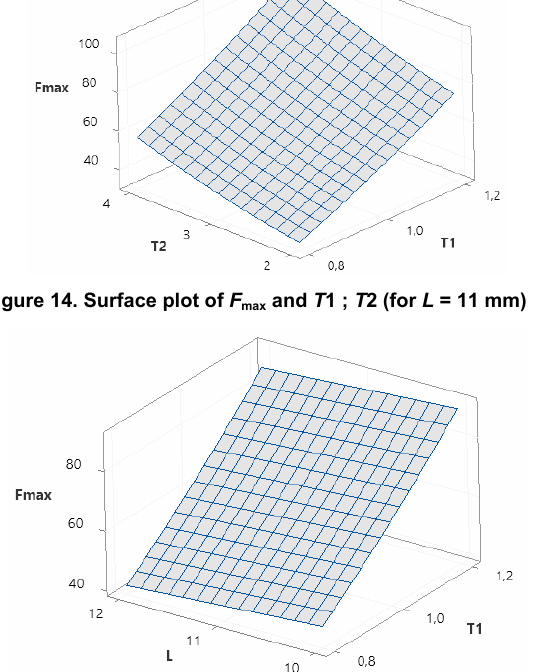
Figure 12. Surface plot of ν and T 2; L (for T 1 = 1 mm)